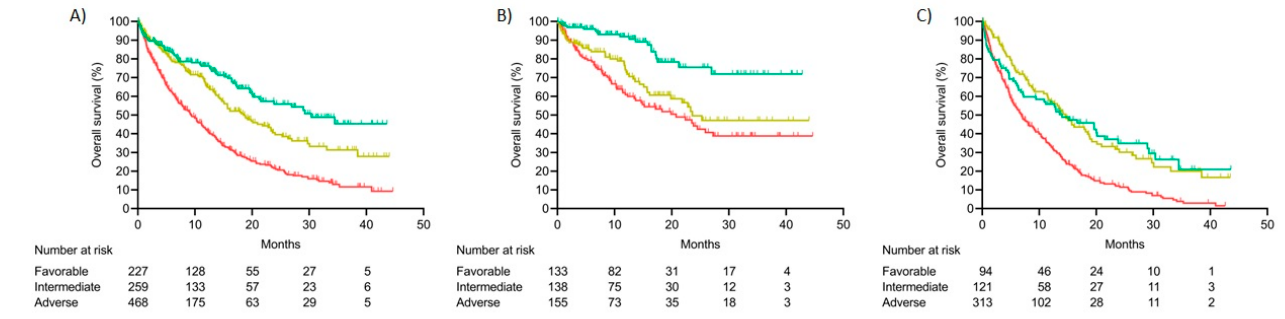
Figure 8. Overall survival according to new genomic risk score: ( A ) Global cohort, ( B ) Patients < 65 years, ( C ) Patients ≥ 65 years.